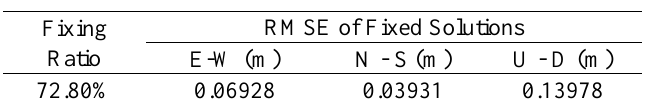
Table 4. Statistic of dual frequency observation on obstructed area